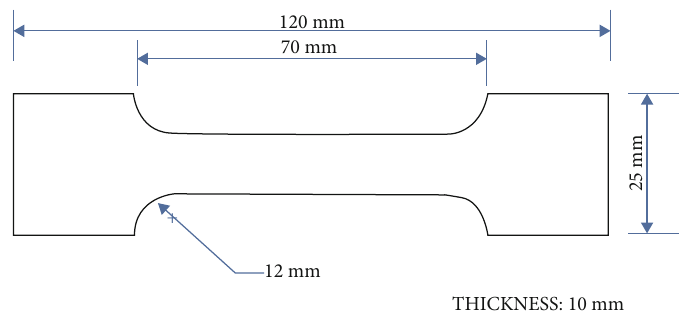
Figure 1: Size of the